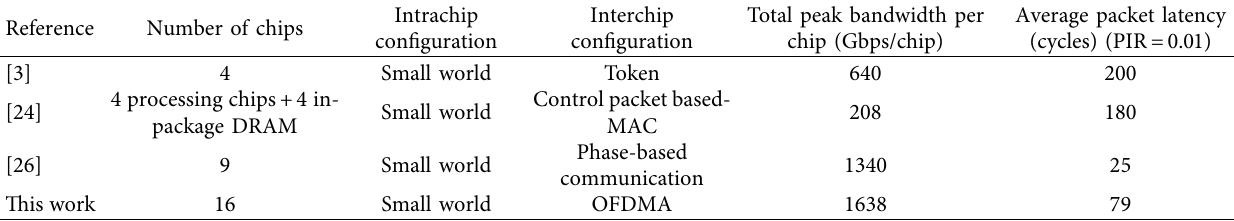
Table 3: The comparison of the proposed THz multichip system with the related